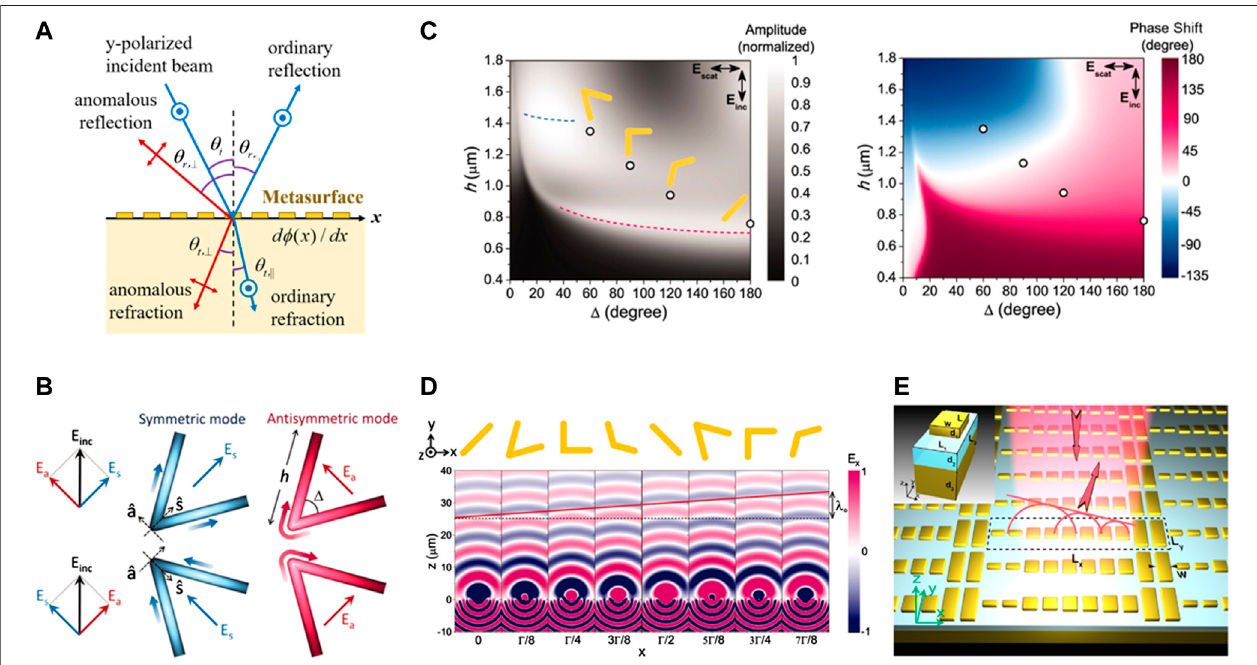
FIGURE 1 | (A) Generalized Snell ’ s law of refraction and re fl ection: Schematic of anomalously refracted and re fl ected beams for cross-polarized scattered beams. (B) V-shaped nanoantenna supports symmetric and antisymmetric modes, which are excited by cross-polarized components of the incident light. There is a π phase difference between the mirror structures [176]. (C) Simulated amplitude and phase shift of the cross-polarized scattered light for V-shaped nanoantennas with different length and opening angle of gold nanorods at wavelength of 8 μ m [176]. (D) Anomalous refraction phenomenon caused by phase discontinuities with a gradient metasurface consisting ofV-shaped nanoantenna array [176]. (E) Anomalous refraction phenomenon caused bymetasurface operating in re fl ection withaback ground plane [141]. Figure reproduced with permission from: (B) – (D) , © 2011, American Association for the Advancement of Science (AAAS); (E) , © 2012, American Chemical Society